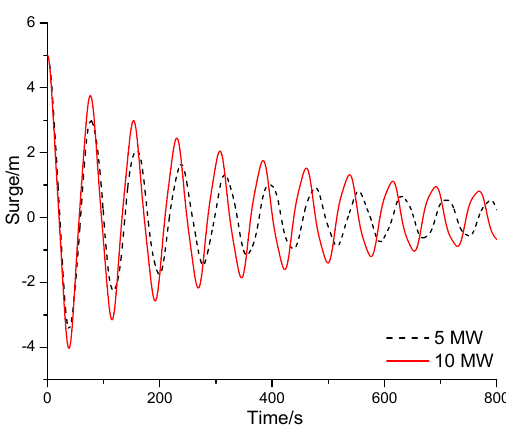
Figure 8. Time histories of surge decay test. Table 5. Natural frequencies of the NREL (National Renewable Energy Laboratory) 5 MW and DTU (Danish University of Science and Technology) 10 MW